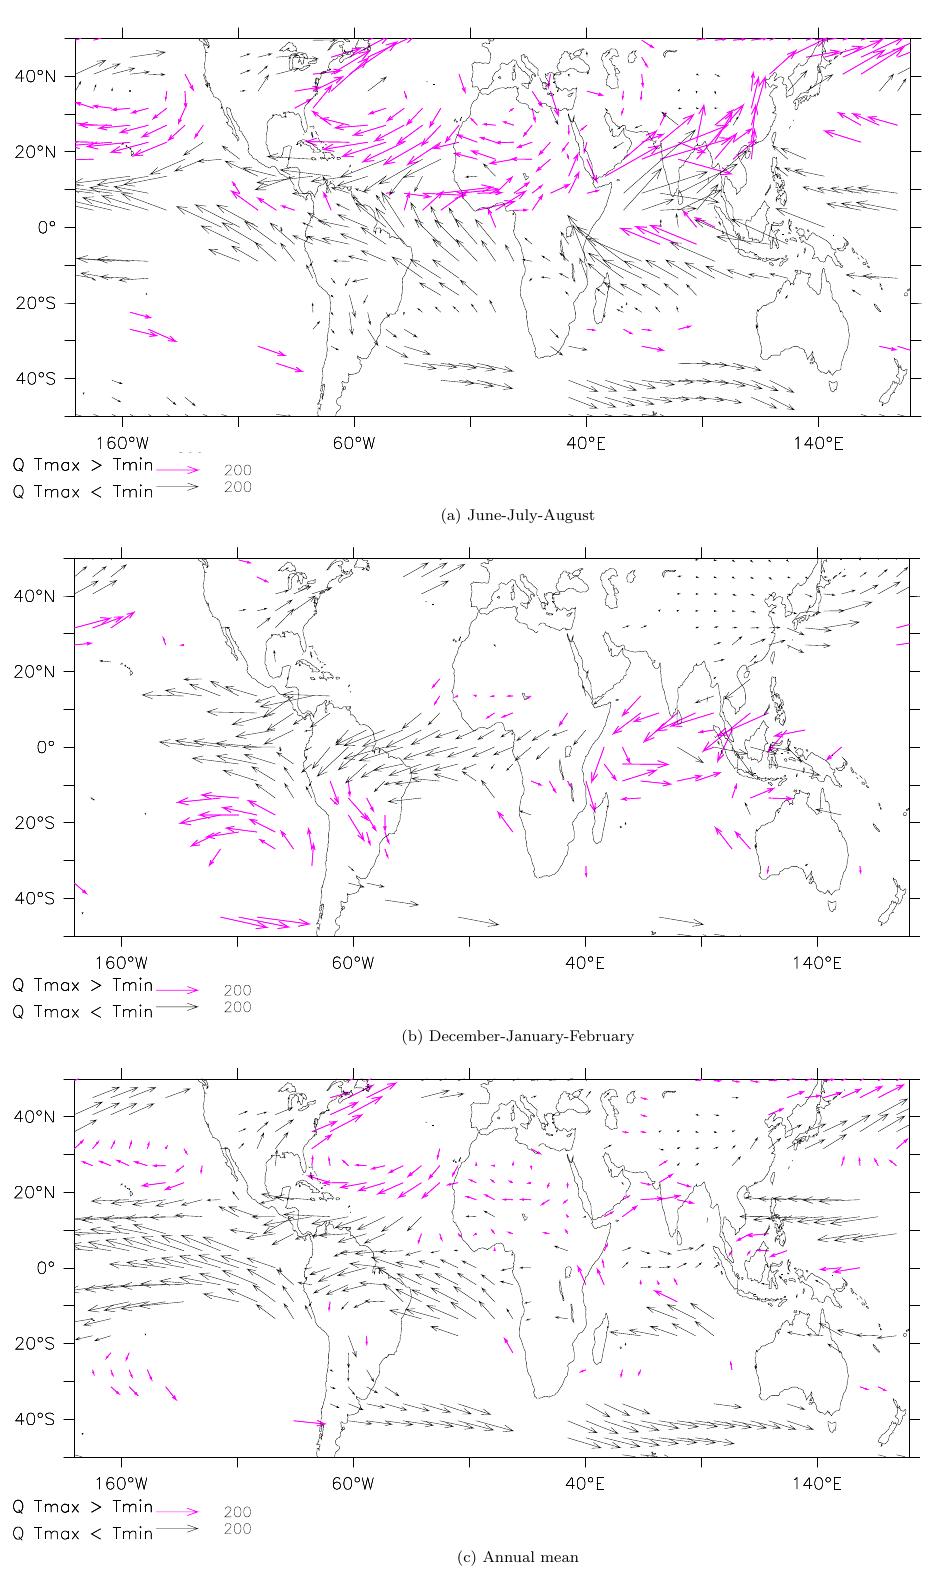
Figure 7. Moisture transport in T max for JJA (a) , DJF (b) and annual mean (c) , vertically integrated, in kg(ms) − 1 . Purple vectors indicate larger moisture transport during T max than during T min . Every seventh arrow in the x direction is drawn and every fourth arrow in the y direction. Results are only shown where the differences are statistically significant at 95% (based on a two-sided Student t